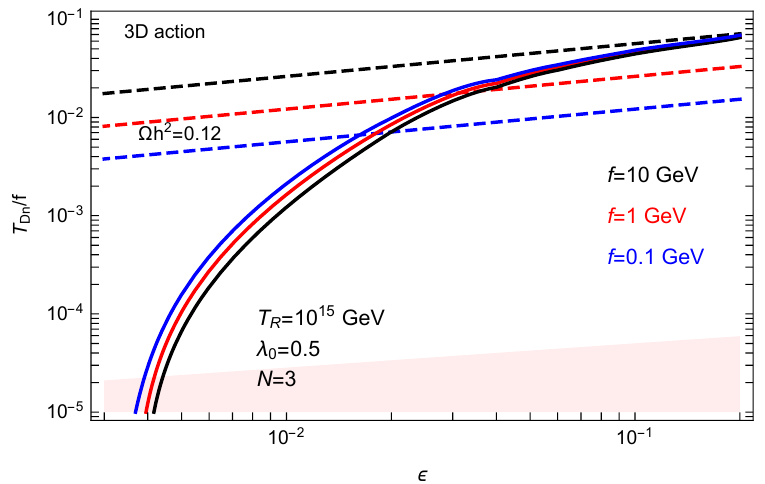
Figure 2 . Nucleation temperature in units of f as a function of the anomalous dimension of the operator [ O ] = 4 + (cid:15) . Solid lines corresponds to tunnelling transitions computed with the 3d euclidean action, that we find dominant in the region of interest. The main difference from ref. [51] is due to the fact that the transition takes place during radiation domination with Hubble dominated by the SM degrees of freedom. DM abundance is reproduced where dashed lines intersect the nucleation curves. We neglect effects of cannibalism as they give small corrections. In the shaded region the dark sector vacuum energy dominates the energy